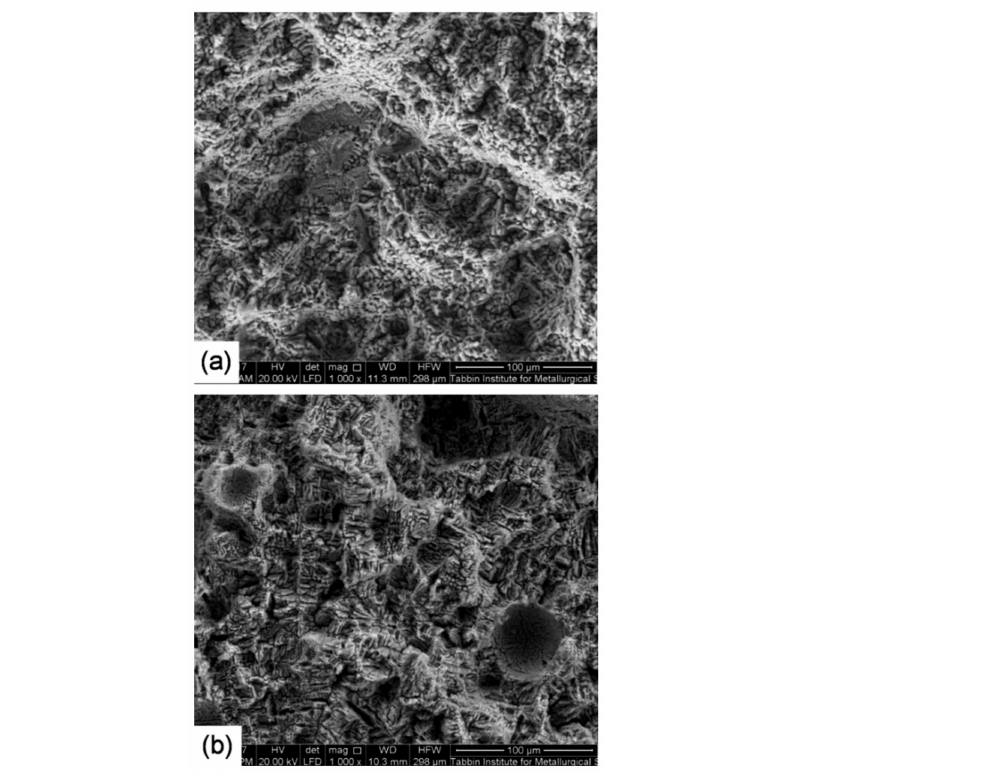
Figure 16. SEM photographs of the tensile fracture surface of specimens taken from the low heat input ( a ) and the high heat input ( b ) welded